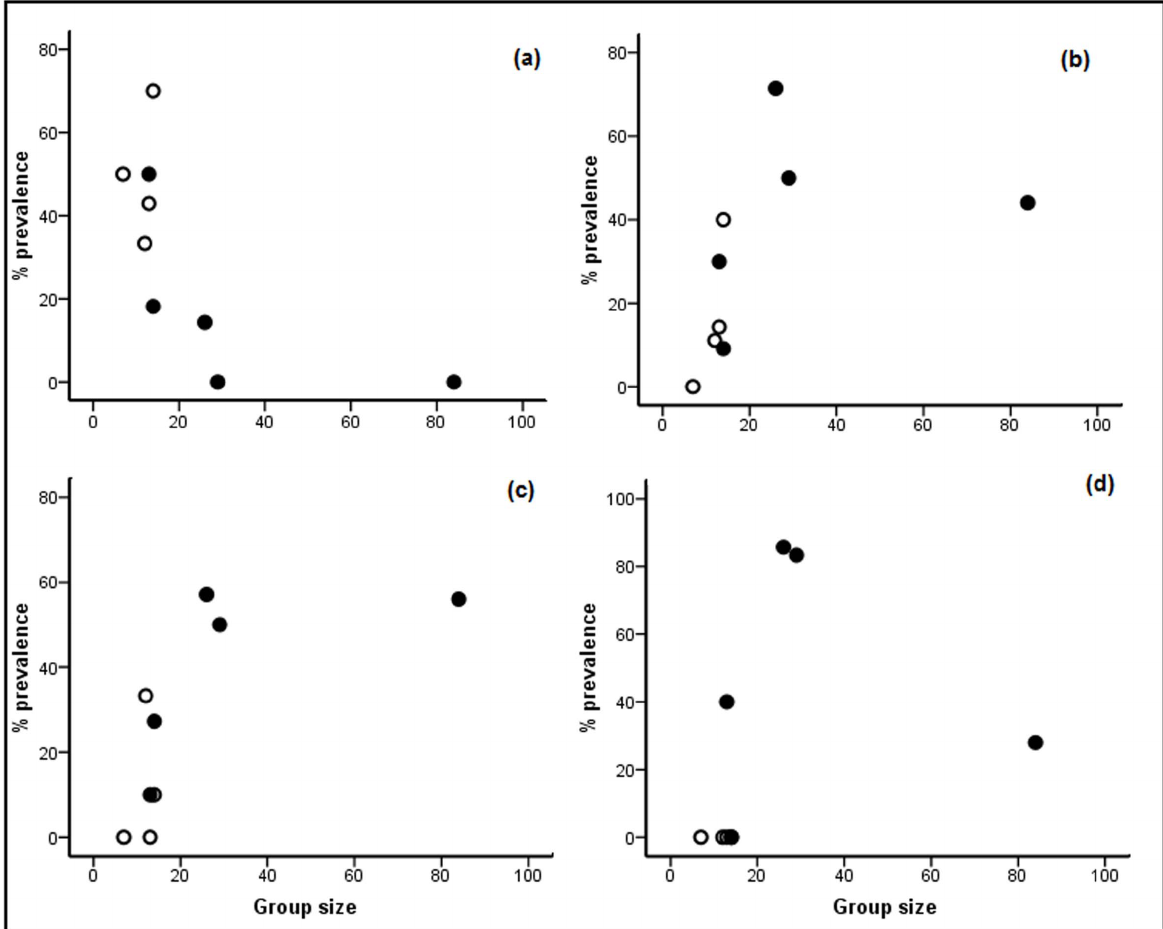
Fragment name Prevalence (%) Ancylostoma Bunostomum Haemonchus Strongyloides Trichuris Cotylophoron Moniezia Diphyllobothrium Balantidium